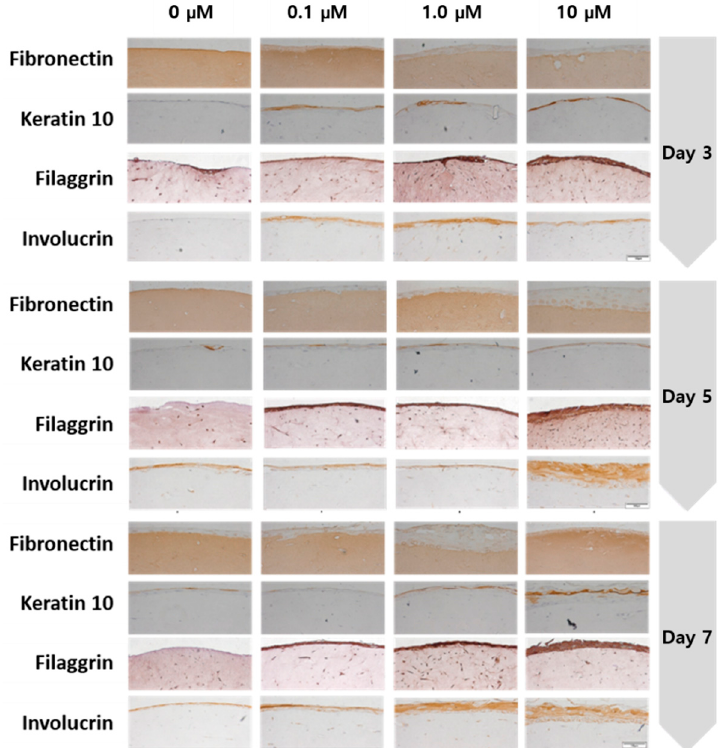
Figure 9. Immunohistochemistry stained images of the fibronectin, keratin 10, filaggrin, and involucrin for the sample as a function of the coenzyme Q10 concentration following 3 days, 5 days, and 7 days of air exposure (bar = 100 μ m).